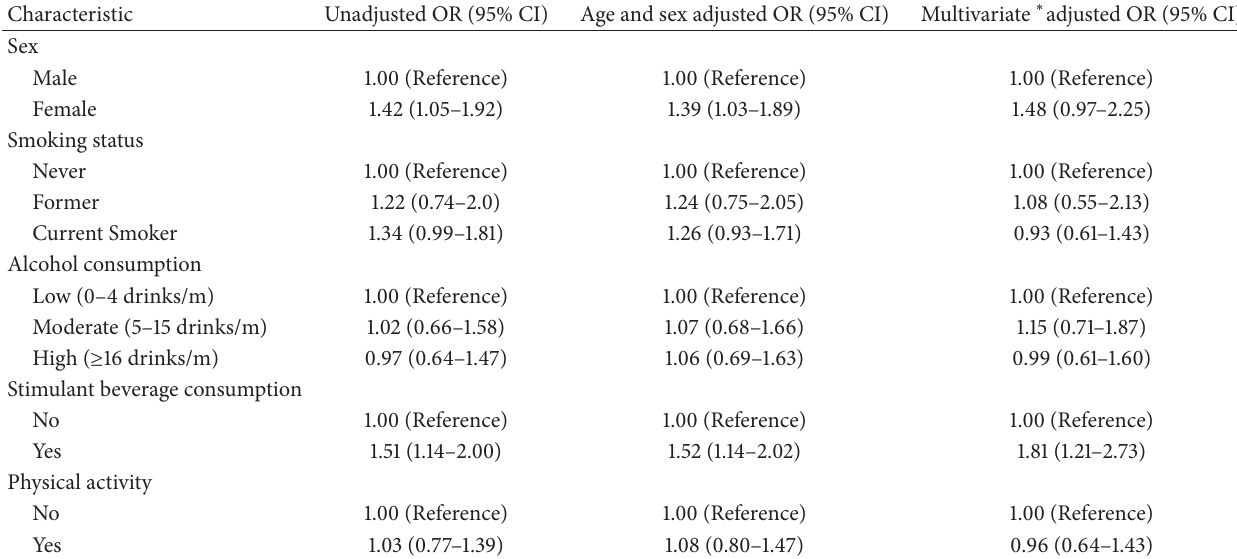
Table 3: Odds ratio (OR) and 95% confidence intervals (CI) for poor sleep